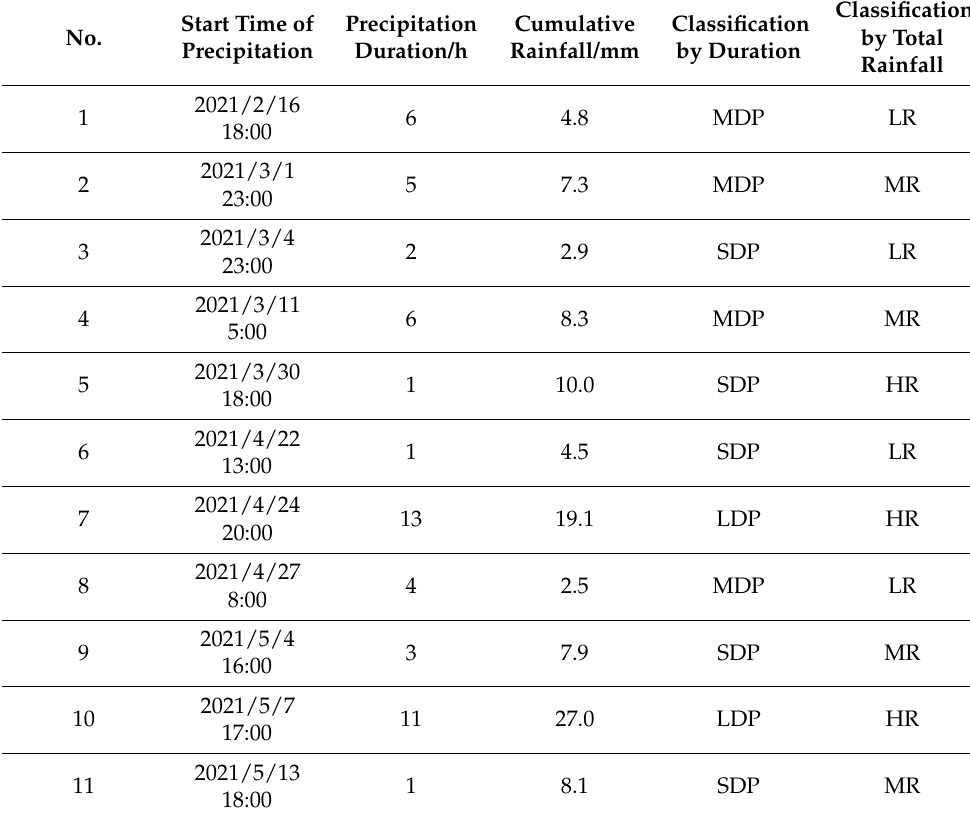
Table 1. Cases information of precipitation at Jian’ou station during